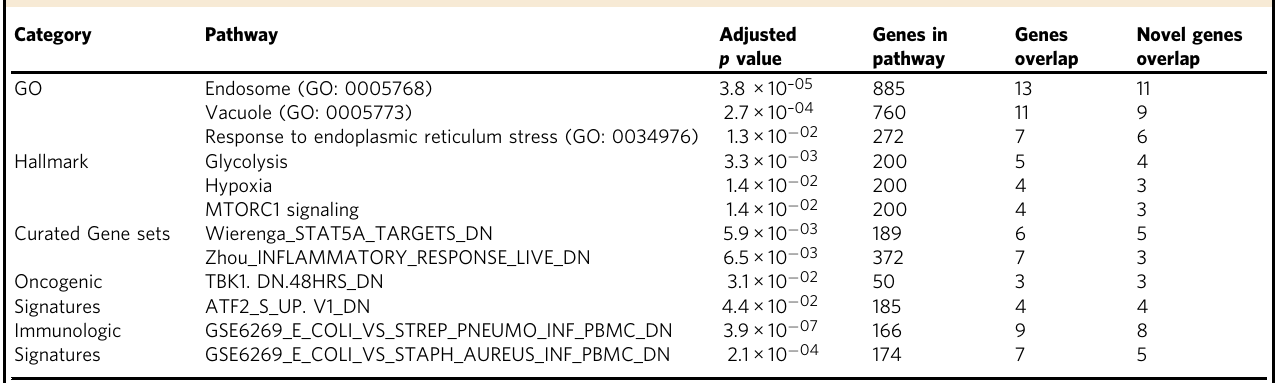
Several selected top pathways containing novel genes across different categories are shown. See Supplementary Data 3 and 4 for results on all signi fi cant pathways and transcription factor target gene- sets for the selected